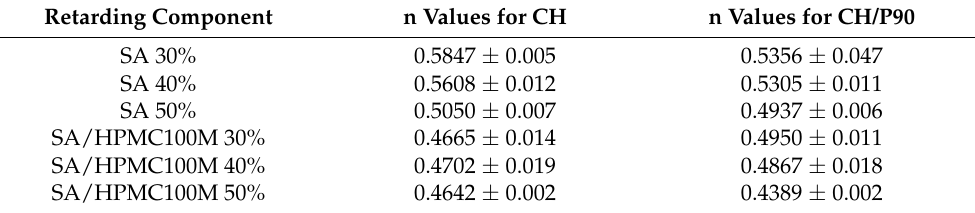
Table 6. Values of power law index n ( − ) of the dispersions of tableting materials in PBS pH 6.8. Retarding Component n Values for CH n Values for CH/P90 SA 30% 0.5847 ± 0.005 0.5356 ± 0.047 SA 40% 0.5608 ± 0.012 0.5305 ± 0.011